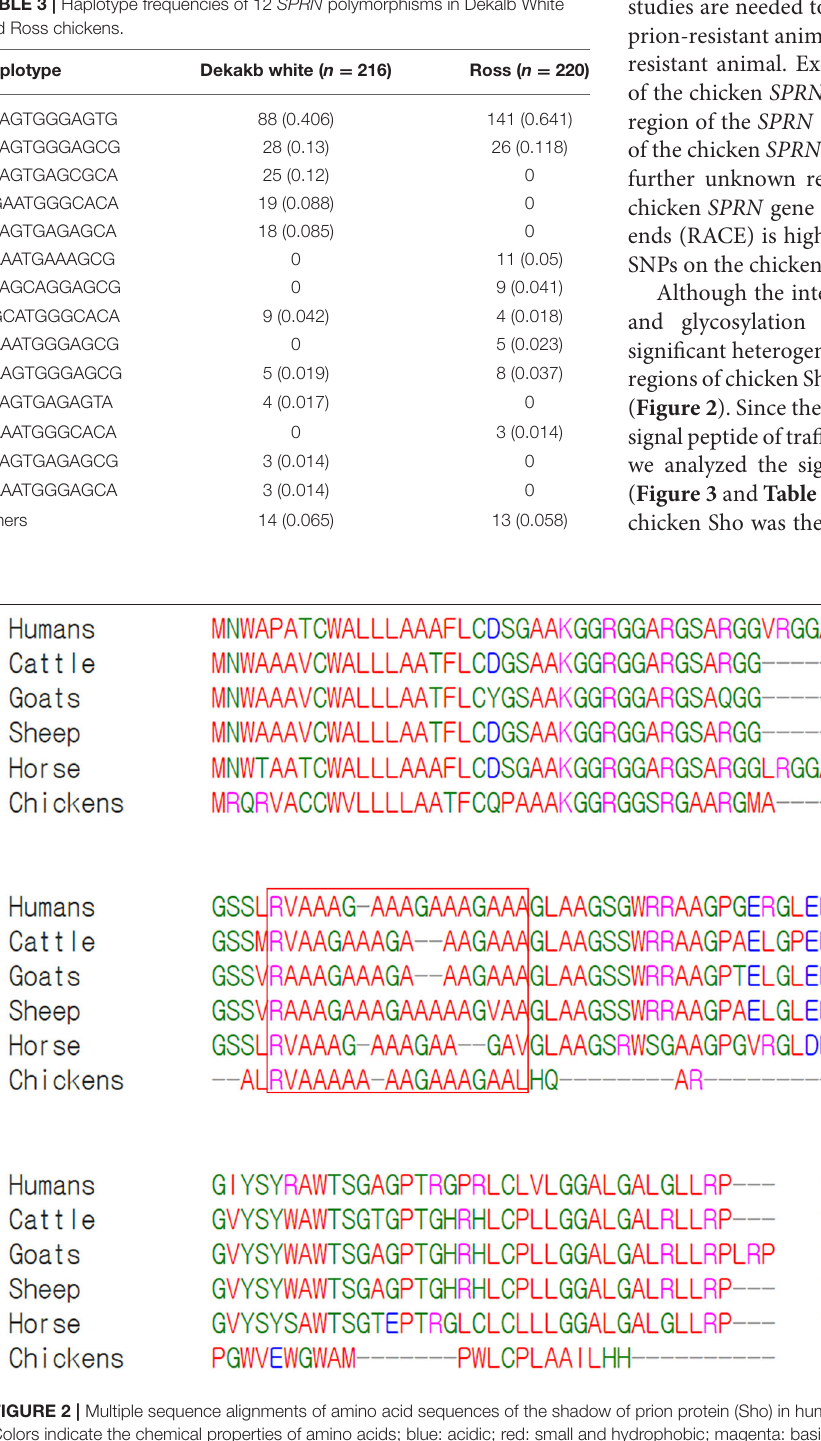
Frontiers in Veterinary Science |